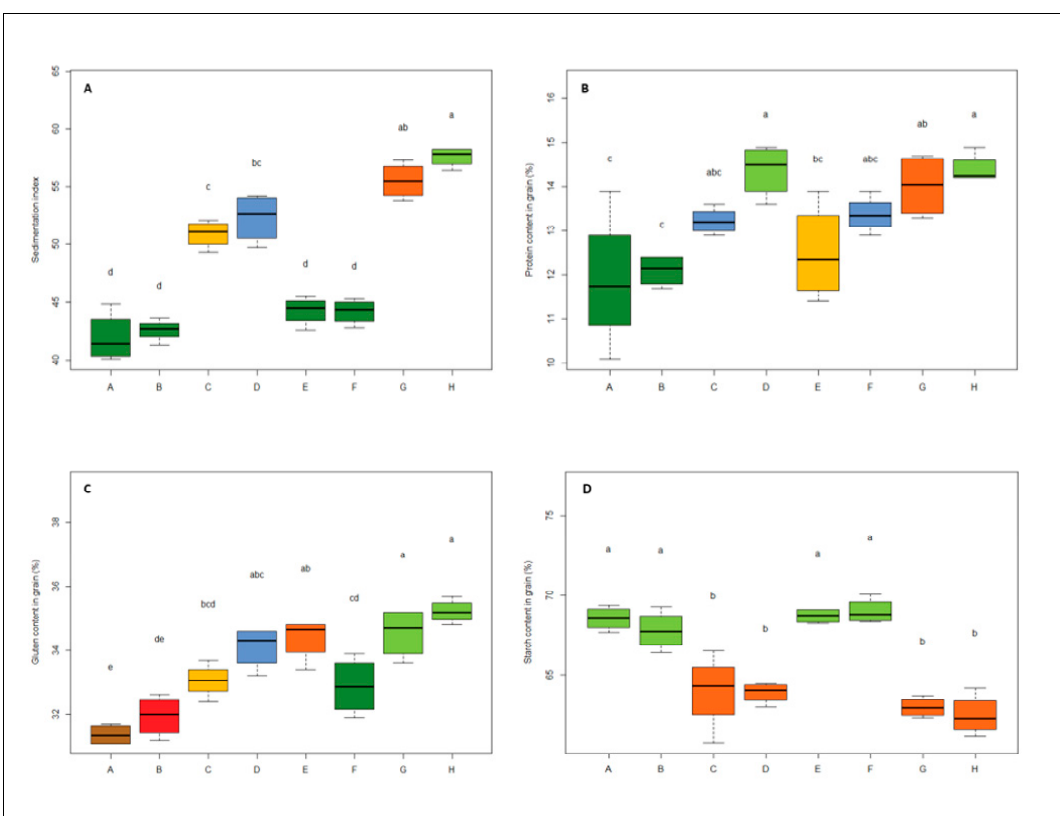
Figure 7. ( A ) Sedimentation index (SI); ( B ) protein (P); ( C ) gluten (G); ( D ) starch (S) content of wheat grains: concentrations (ASA3, ASA5) *terms of applications (T1 / T2, T3 / T4) *years (2013, 2014). Boxes: the interquartile range. Lines across the boxes: the average of the values. The line above and below the vertical dashed lines: the maximum and minimum values. Boxes of the same color indicate a group of similar objects. The letters a, ab, b, ... indicate similar objects in order of highest average value. A = ASA3 *T1 / T2 *2013; B = ASA5 *T1 / T2 *2013; C = ASA3 *T1 / T2 *2014; D = ASA5 *T1 / T2 *2014; E = ASA3 *T3 / T4 *2013; F = ASA5 *T3 / T4 *2013; G = ASA3 *T3 / T4 *2014; H = ASA5 *T3 / T4